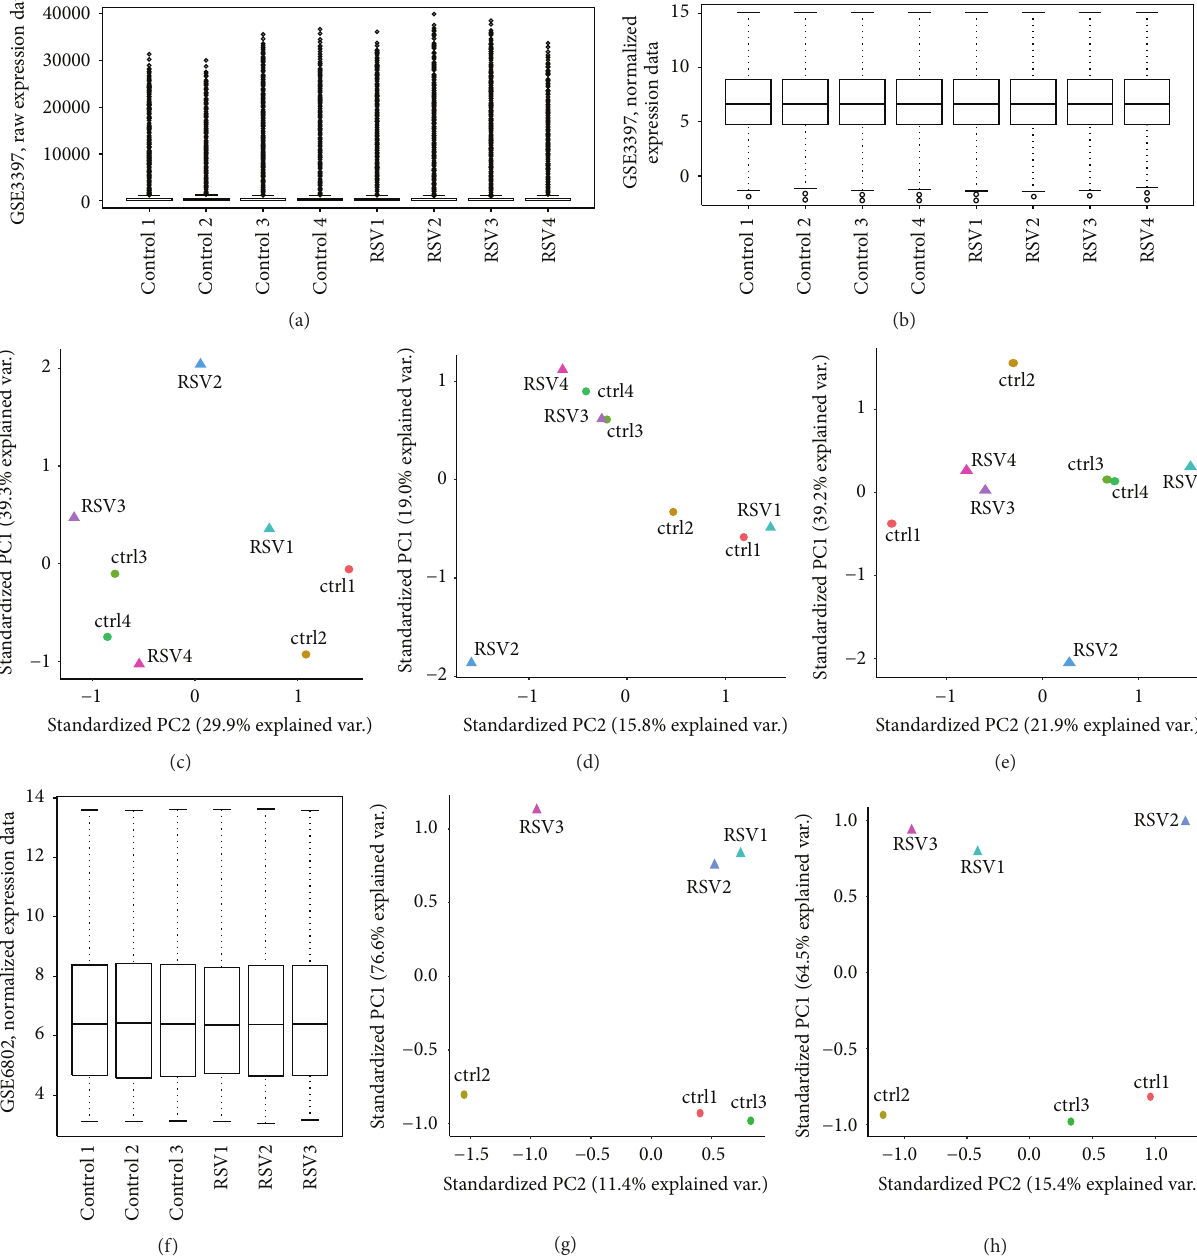
Figure1:PreprocessinganalysisofGEOdatasetsGSE3397andGSE6802.(a)BoxplotofGSE3397,rawexpressiondata.(b)BoxplotofGSE3397, normalized expression data. (c) Principal component analysis of GSE3397, raw expression data. (d) Principal component analysis of GSE3397, normalized expression data. (e) Principal component analysis of GSE3397, normalized and batch corrected expression data. (f) Boxplot of GSE6802, RMA normalized expression data. (g) Principal component analysis of GSE6802, normalized expression data. (h) Principal component analysis of GSE6802, log 2 transformed RMA normalized expression